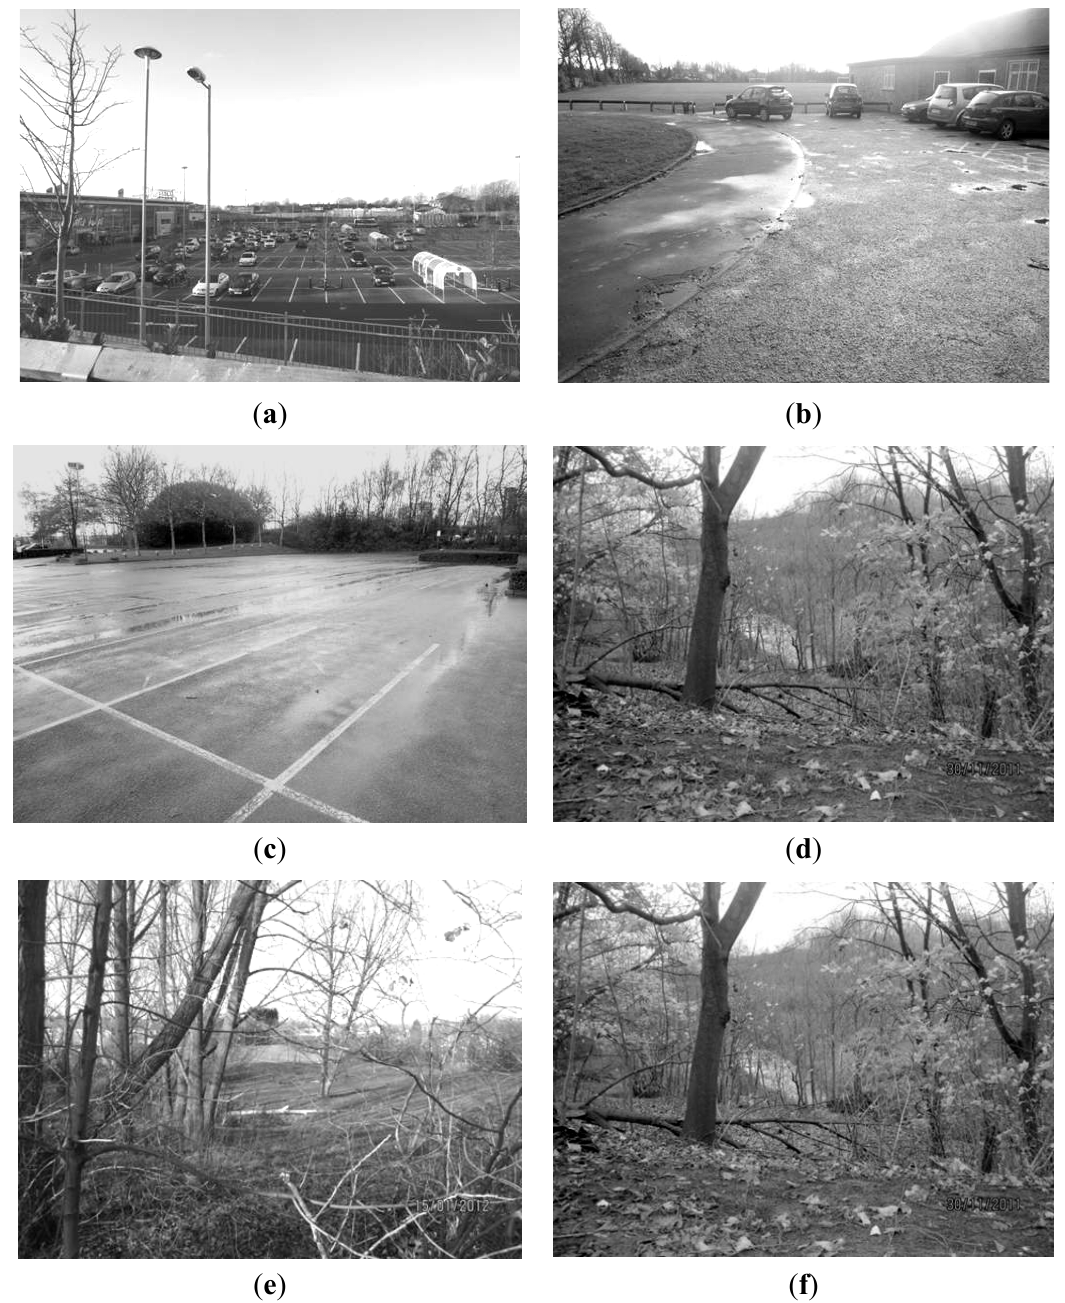
Figure 1. Relative ranking values for the variable habitat for species (%). Ascending order ( i.e ., from highly inadequate to highly adequate habitat) based on the authors’ expertise: ( a ) 9%; ( b ) 23%; ( c ) 45%; ( d ) 62%; ( e ) 70%; and ( f ) 82%. All photographs were taken by the authors and Nathan Somerset in 2012 and 2013 (The University of